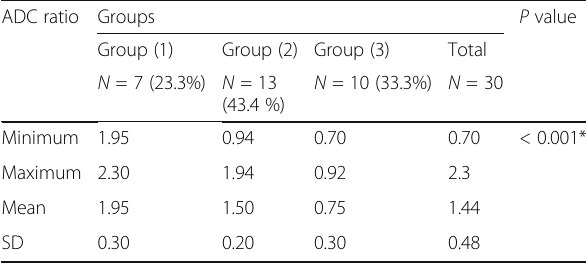
Table 4 Comparison of ADC ratio between the studied groups ADC ratio Groups